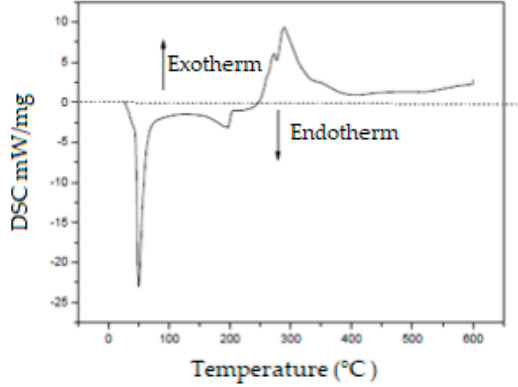
Figure 5. DSC profile of lauric acid.